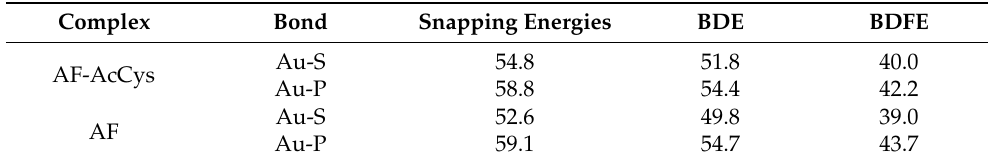
Table 2. Snapping energies, bond-dissociation enthalpies (BDE) and bond-dissociation Gibbs free energies (BDFE). All values are in